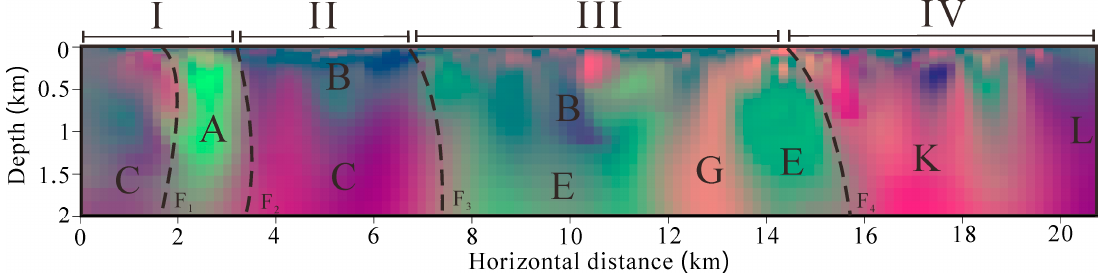
Figure 17. Comprehensive geological interpretation profile. Table 4. Statistical table of stratigraphic lithology.